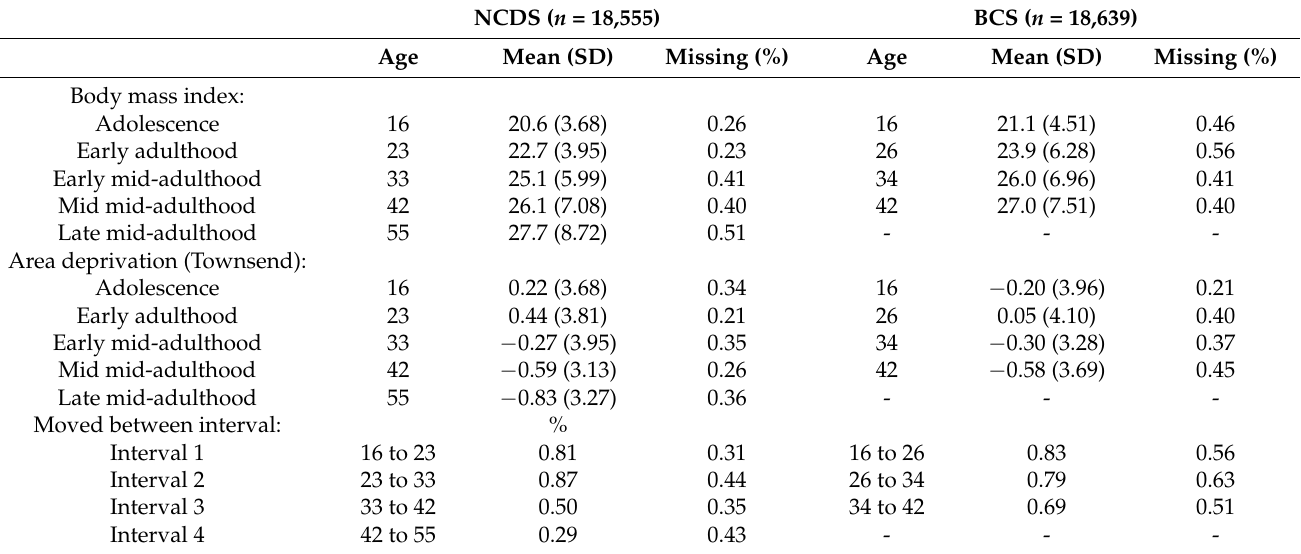
Table 1. Sample characteristics, National Child Development Study (NCDS) and 1970 British Cohort Study (BCS). NCDS ( n = 18,555) BCS ( n = 18,639) Age Mean (SD) Missing (%) Age Mean